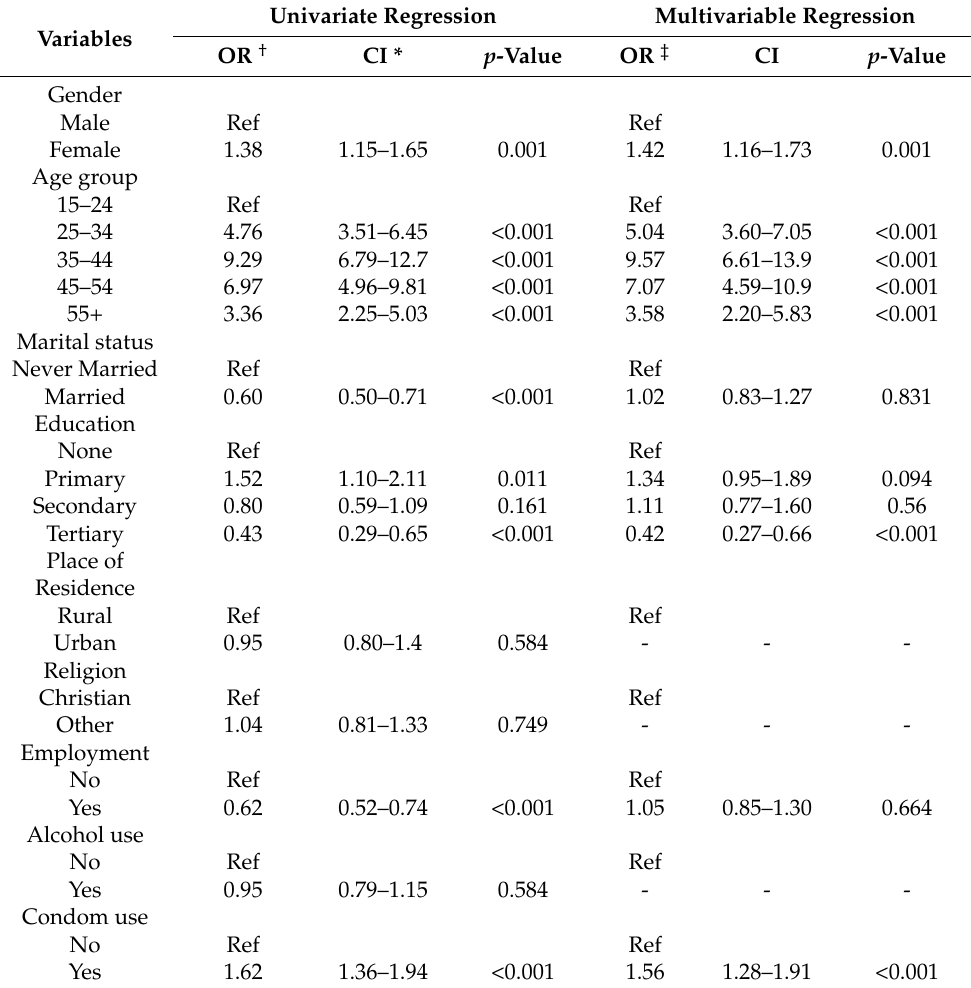
Table 2. Univariate and multivariable logistic regression models of risk factors associated with human immunodeficiency virus (HIV)